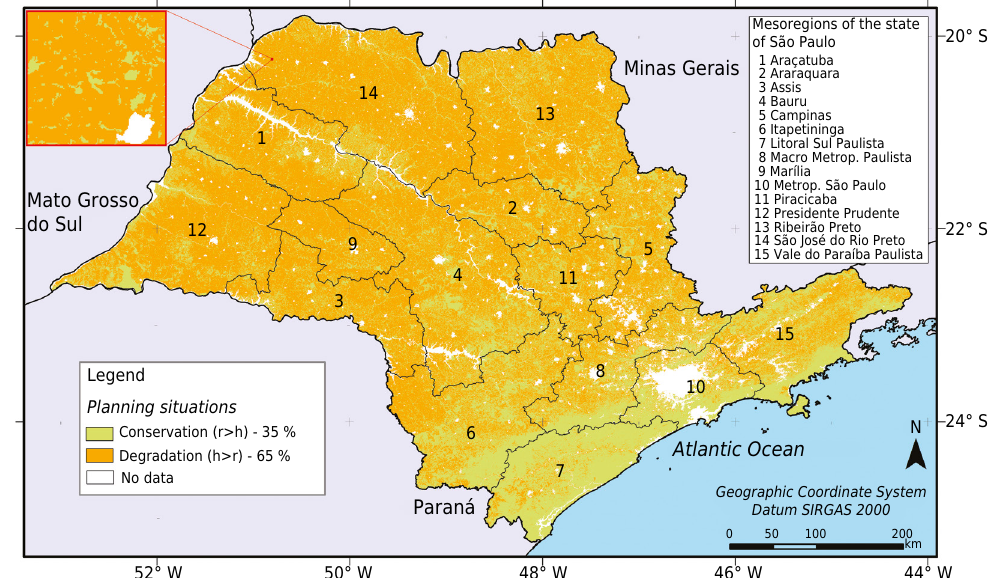
Figure 4. Map of planning situations in state of São